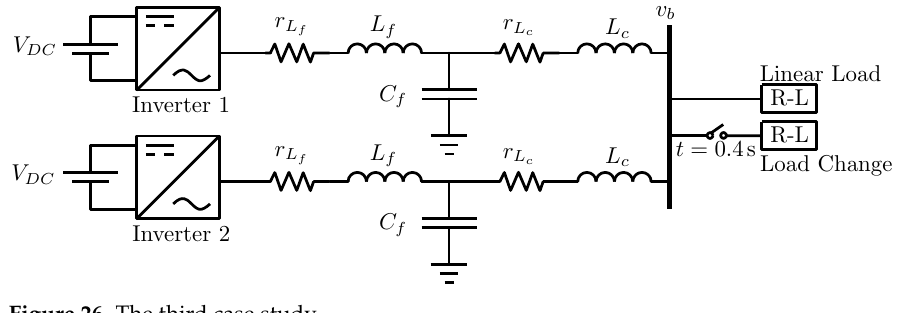
Figure 26. The third case study.